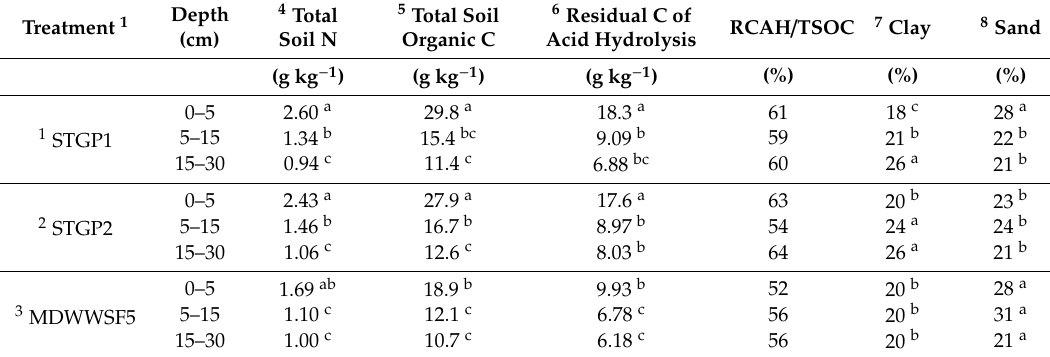
Table 1. Treatment (southern tall grass prairie watersheds 1, 2 (STGP) 1 and 2 and the minimal disturbance, winter wheat summer forage 3 (MDWWSF) watershed 5, by depth soil interactions for total soil nitrogen 4 (TSN), total soil organic C 5 (TSOC), residual C of acid hydrolysis 6 (RCAH), 7 Clay, and 8